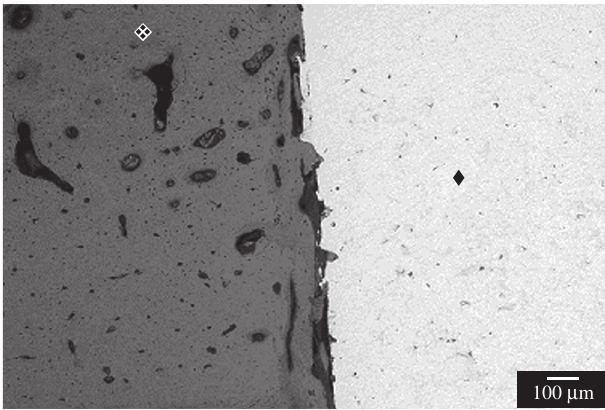
Figure 6. SEM photomicrograph of dense titanium scaffold (  ) 4 weeks after implantation in rabbit tibia ( 